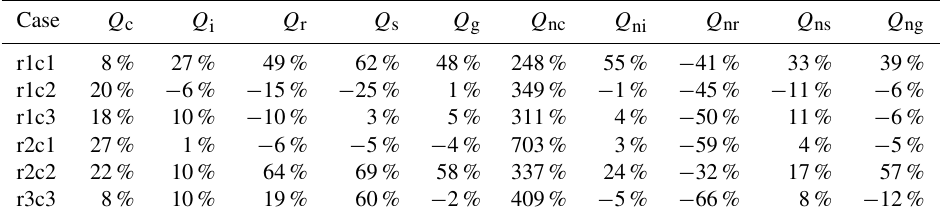
Table 3. The mean differences in percentage of FFBB to FF (i.e., ( FFBB − FF )/ FF × 100% ) for each selected case over the main convection area in the Sumatra region (r1) and the Borneo region (r2). Q c , Q i , Q r , Q s , and Q g represent cloud, ice, rain, snow, and graupel mass concentrations, respectively. Q nc , Q ni , Q nr , Q ns , and Q ng are the number concentration for each hydrometeor. Case Q c